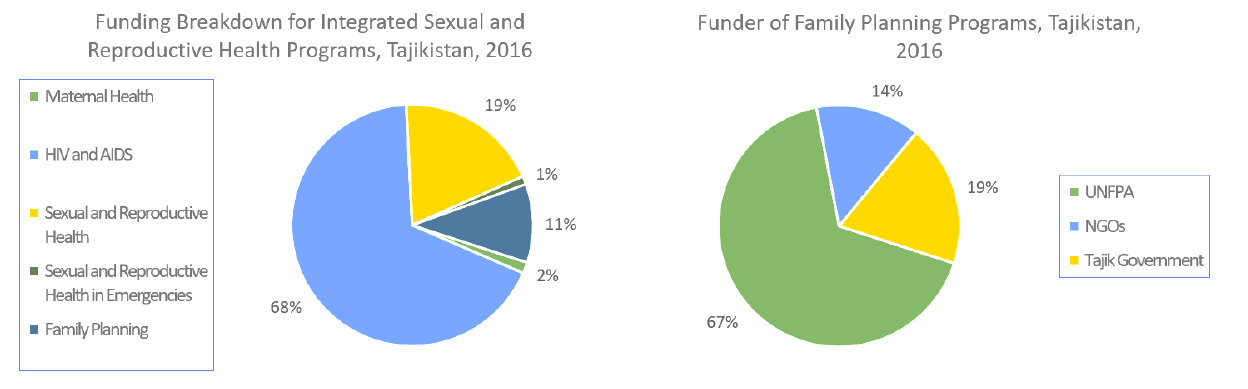
Figure 2. Family planning program funding, Tajikistan,